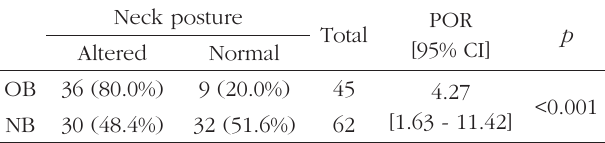
Table 2. Altered neck posture in the groups: mouth breathers (OB) and nasal breathers (NB).